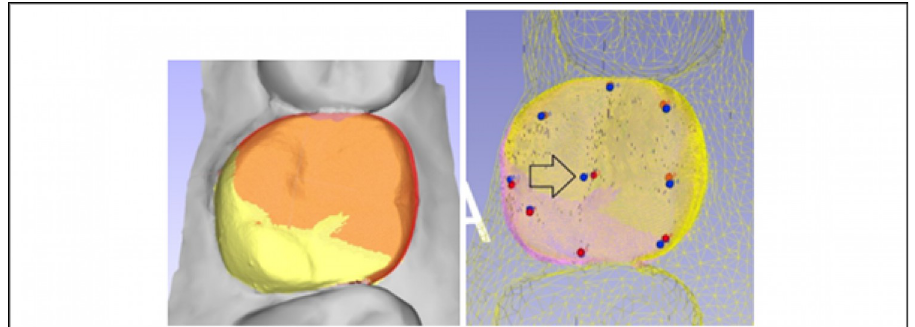
Fig 7. A & B: Superimposition of teeth for comparison (left). Measurement of the geometric morphology and 3D position by locating the anatomical landmarks of a tooth such as cusp tips and fossae as well as the center of a tooth (arrowed) respectively